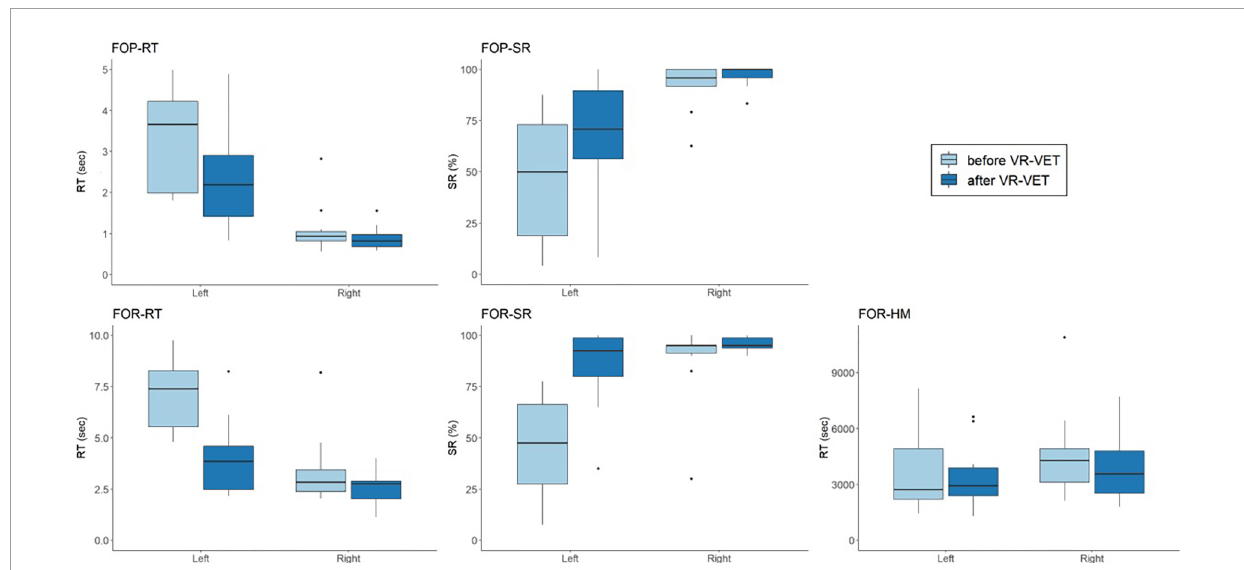
FIGURE5 Comparisons of VR-VET effects on FOPR test between the right and left hemispaces. FOP, field of perception; FOR, field of regard; RT, response time; SR, success rate; HM, head movement; VR-VET, virtual reality-visual exploration